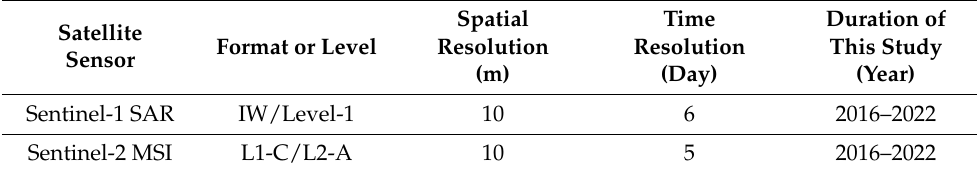
Table 1. Various parameters of satellite